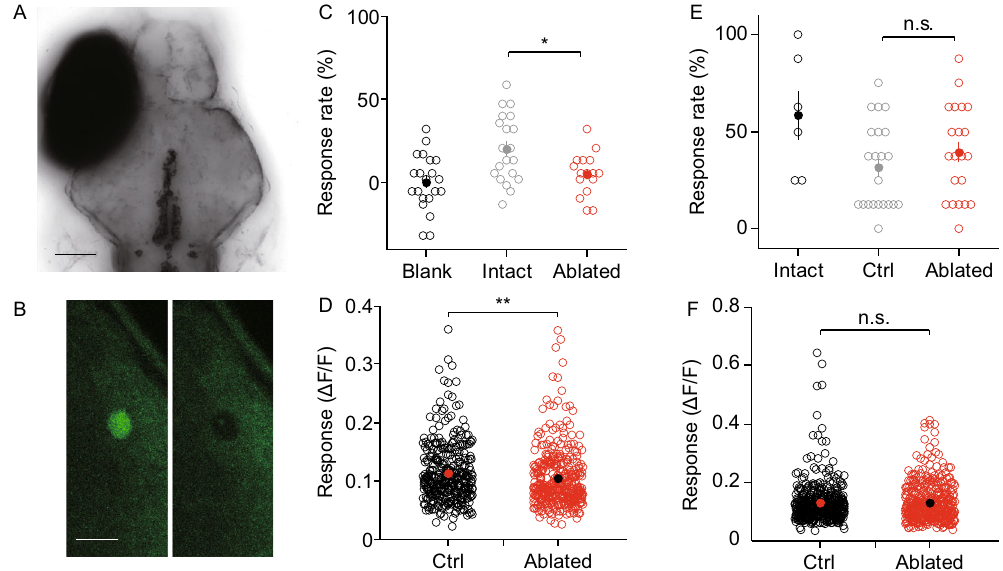
Figure 5. SINs are crucial for prey capture but not looming-evoked escape. (A) Confocal image of a 7 dpf larva with ipsilateral eye removed. Scale bar, 100 μ m. (B) SIN before (Left panel) and after (Right panel) laser ablation. Soma is destroyed and cell debris is visible. Scale bar, 10 μ m. (C) Prey capture reduced in SIN ablated larvae ( n = 16) relative to control ( n = 20, P = 0.0134, Student ’ s t - test). Blank indicates no fi sh control. (D) Prey-like moving dot stimulation (3°) evoked response in PVNs reduced in SIN ablated larvae ( n = 348 from 13 larvae) relative to control ( n = 362 from 15 larvae, P = 0.0011, Wilcoxon rank-sum test). (E) Looming evoked escape unaffected in SIN ablated larvae ( n = 21) relative to control ( n = 22, P = 0.3132, Wilcoxon rank-sum test). Intact fi sh serve as control. (F) Looming evoked tectal responses unaffected in SIN ablated larvae ( n = 392 from 6 larvae) relative to control ( n = 414 from 7 larvae, P = 0.9004, Wilcoxon rank-sum